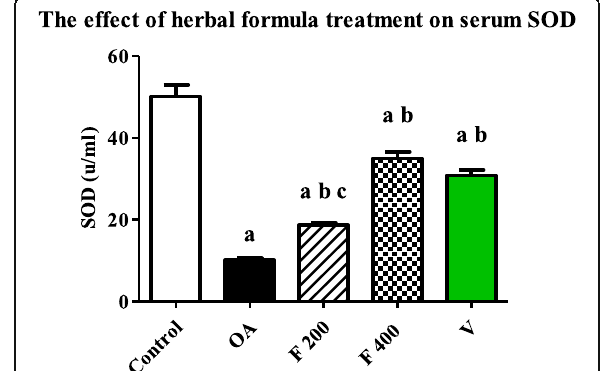
Fig. 5 Serum level of SOD (U/ml) in the experimental groups. Herbal formula treatment increased serum level of SOD in the osteoarthritic rats at the end of 1 month treatment; C = control; OA = osteoarthritis; F 200 = herbal formula 200 mg/kg; F 400 = herbal formula 400 mg/kg; V = Voltaren. Results were expressed as mean ± SEM and analyzed using one-way ANOVA followed by Bonferroni ’ s post hoc test, a = Significant from control at P < 0.0001, b = Significant from OA at P < 0.0001, c = Significant from F 400 at P <